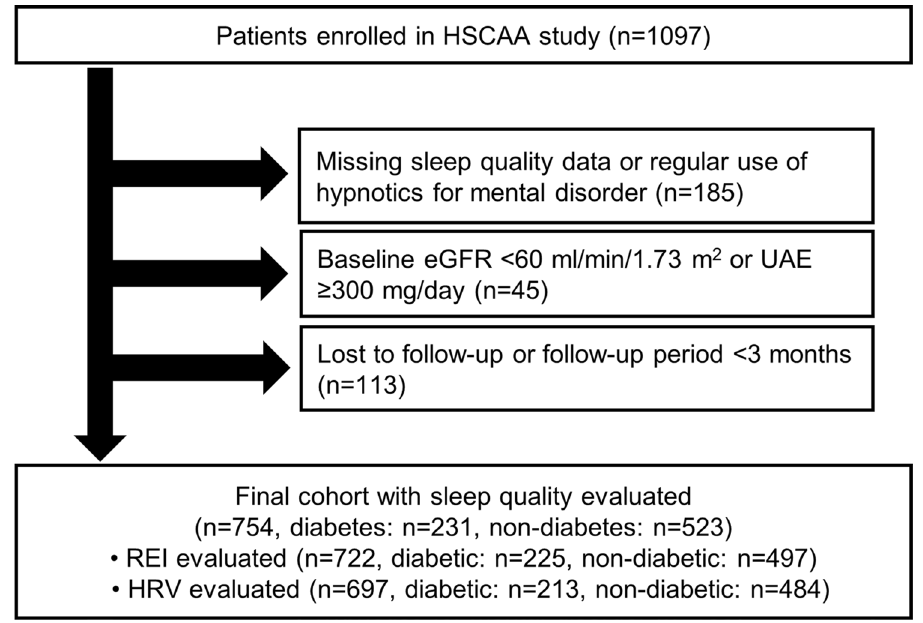
Figure 1. Flowchart of criteria for selecting study participants. HSCAA hyogo sleep cardio-autonomic atherosclerosis, eGFR estimated glomerular filtration rate, UAE urinary albumin excretion, REI respiratory event index, HRV heart rate